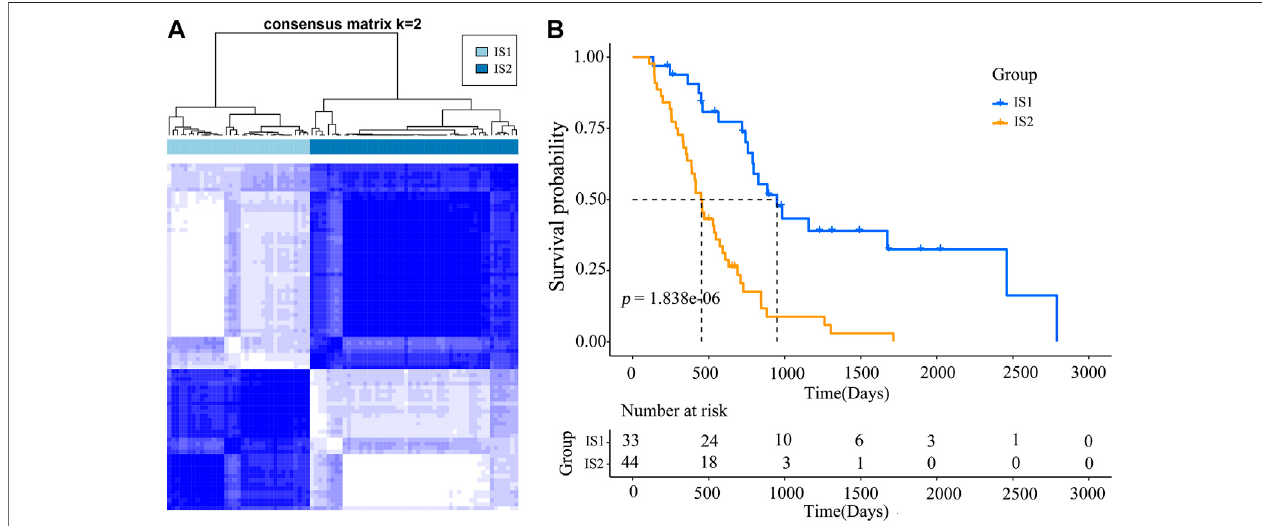
FIGURE 4 | Immunophenotyping for mesothelioma (A) Consensus clustering analysis of samples on the basis of the expression of immune-related genes (B) Kaplan-Meier curves for the two immune subtypes.